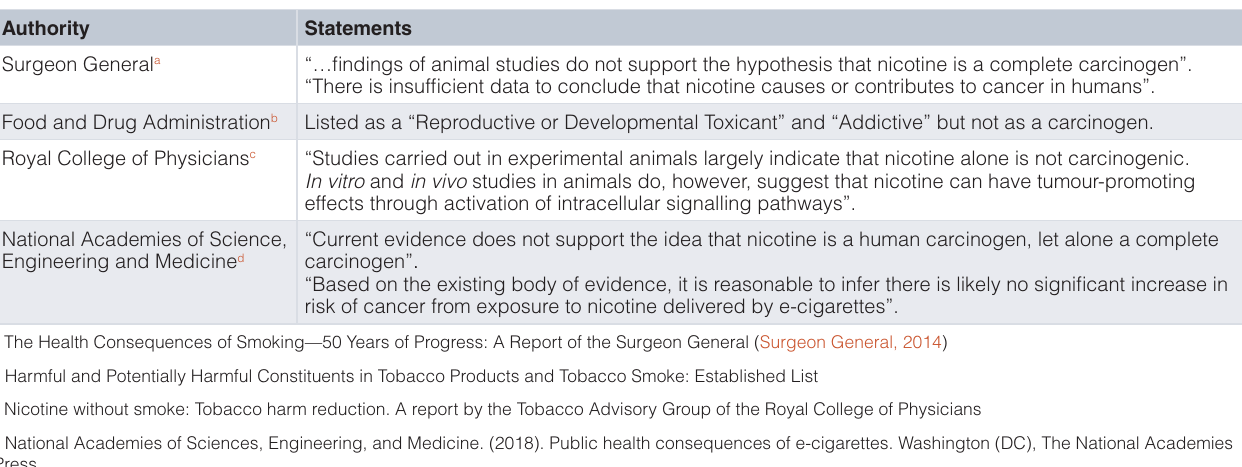
Table 1. Summary of official statements surrounding the carcinogenic properties of